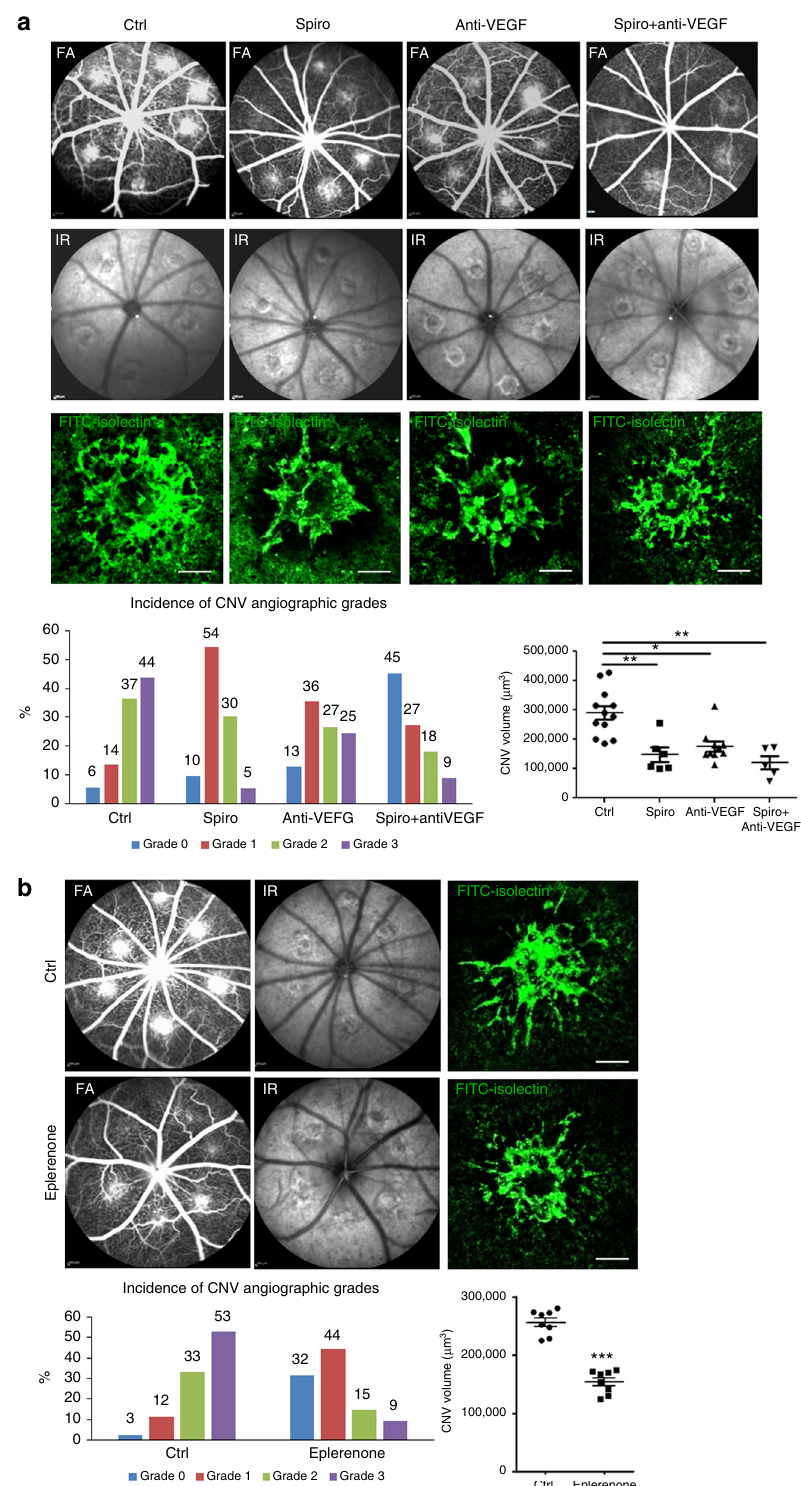
Fig. 2 Spironolactone and eplerenone reduce CNV in a rat nAMD model. a Spironolactone (Spiro) signi fi cantly reduces the CNV angiographic grades evaluated on fl uorescein angiography (FA) ( p = 0.0025) and the CNV volume labeled with FITC-isolectin (green) ( p = 0.002) as compared to the control group (Ctrl). Infrared images (IR) are used to localize and check the ef fi cient laser-induced burns. The effect of spironolactone is not different from anti- VEGF in reducing the choroidal neovascular leakage on FA and inhibiting the CNV in rat choroidal fl at-mounts. Combining the two treatments allows an enhanced effect in reducing vascular permeability compared to anti-VEGF alone ( p = 0.0335). b Eplerenone, a more speci fi c MR antagonist, given orally, signi fi cantly reduces CNV angiographic grades ( p = 0.0012) and CNV volumes ( p < 0.0001). Bars: 100 µ m. FA Data are expressed as the incidence of CNV angiographic grades of the total laser impacts in each group. CNV volumes are expressed as mean ± SEM of average CNV size per rat. n represents the number of rats. Linear mixed model was used for statistical analyses. * p < 0.05, ** p < 0.01, *** p <